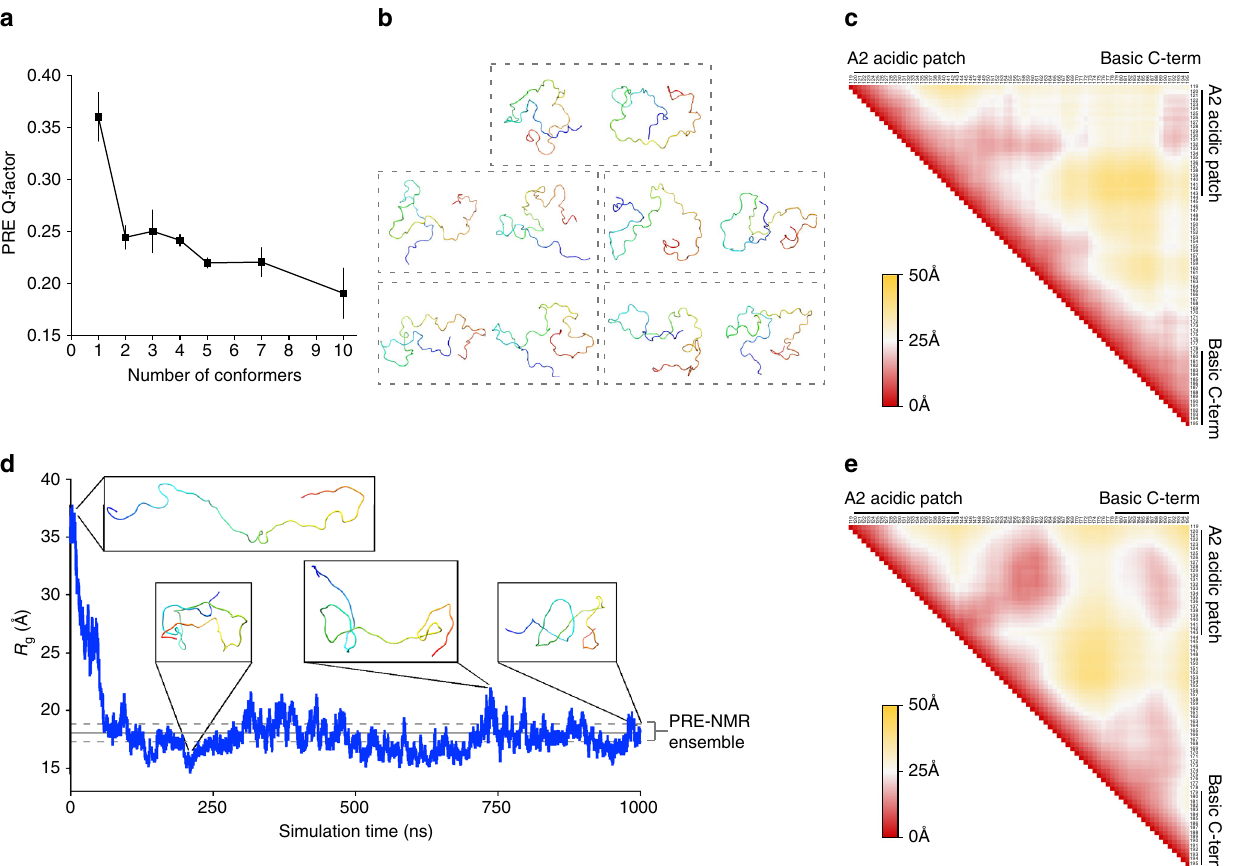
Fig. 4 Ensemble structural modeling and MD simulation of the Npm tail domain. a PRE Q-factor values with standard errors from the top fi ve ensembles out of 50 with a variable number of conformers per ensemble ranging from 1 to 10. 350 ensembles corresponding to 1600 conformers were calculated in total. b Top fi ve PRE-derived two-conformer ensemble models of the Npm tail domain. Each two-conformer ensemble is boxed. Conformers colored blue to red from N-terminus to C-terminus. c Protein C α – C α contact map of the tail derived from the top fi ve two-conformer PRE models in b . Axes are residues of the tail domain from N to C-terminus from left to right and top to bottom. Colored red to yellow by average distance ranging from 0 to 50 Å, respectively. d 1 µ s unrestrained all-atom molecular dynamics (MD) simulation of the Npm tail domain starting from an extended conformation. Radius of gyration ( R g ) measured as a function of simulation time. Representative structures show the starting, the most compact, and the most extended, and the fi nal conformations observed during the simulation. Gray lines are the average and standard deviation of the R g measured from the PRE-NMR 2-conformer ensemble ( b ). e Time-averaged protein C α – C α contact map from the 1 µ s MD simulation using an extended starting model. Same axes and coloring scale as in